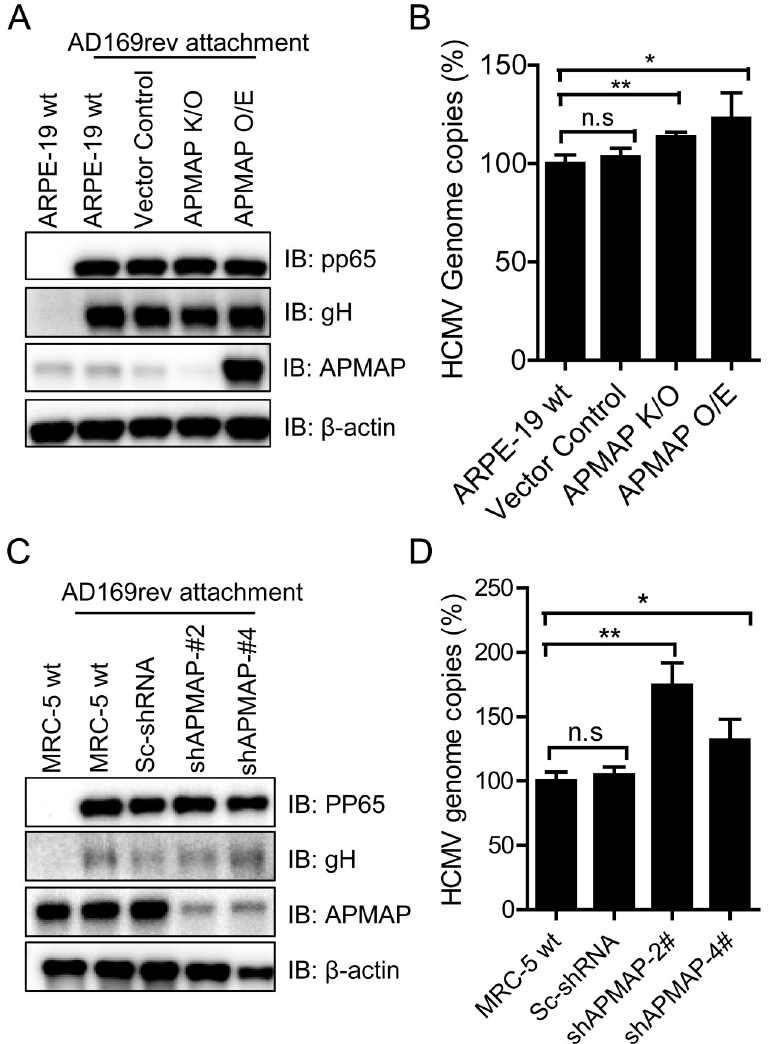
Fig 7. HCMV attachment was not affected in APMAP deficient target cells. ( A-B ) Wildtypte ARPE-19, APMAP K/ O and APMAP O/E cells were seeded in 24-well plate (1 × 10 5 cells/well) for 1 day. The cells were pre-cooled at 4˚C for 10 mins. After removing the medium, 2.4 × 10 6 PFU/well of AD169rev diluted in 200 μ l complete medium was added to the cells and incubated at 4˚C for 90 mins. After washing of unbound virus with cold PBS for 3 times, the cells were collected to determine HCMV attachment either by ( A ) western blot assay to detect viral proteins pp65 and gH, and APMAP with β -actin as loading controls; or by ( B ) qPCR using pp65 specific primers to quantify HCMV genome. Cells genomic DNA and HCMV genome were extracted together using Qiagen kit. The DNA samples were quantified by Nanodrop and same amount of DNA were used as template in qPCR. A plasmid inserted with pp65 genes, pET28a- pp65, was used generated standard curve. The data are shown as percentages of HCMV genomes on cells surface relative to that of wildtype ARPE-19 cells. Relative percentages of HCMV genome copies in vector control, APMAP K/ O and APMAP O/E cells were compared individually to that of wildtype ARPE-19 cells using unpaired two-tailed student t-test for significance analysis. ( C-D ) AD169rev attachment on MRC-5 and APMAP K/D cells were determined as described above by ( C ) western blot and ( D ) qPCR assay, respectively, as described